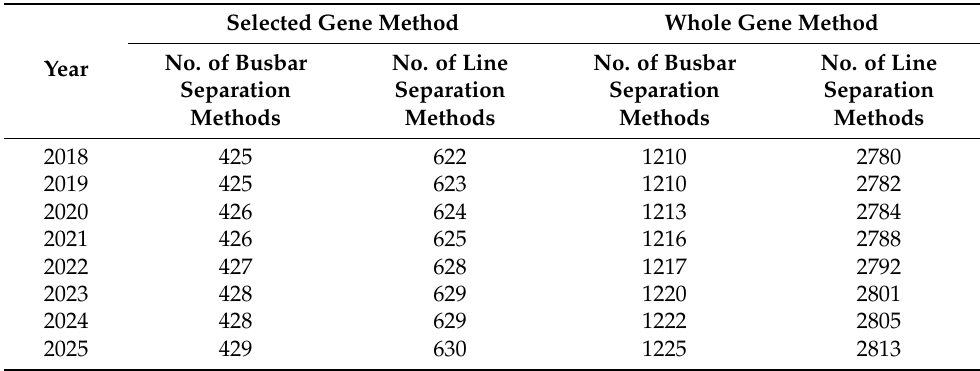
Table 1. Number of chromosomes participating in each